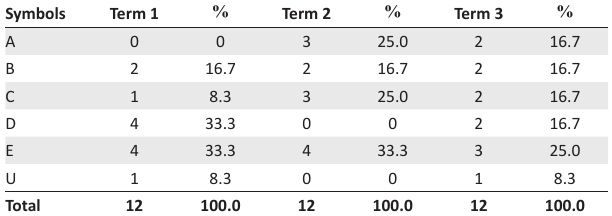
TABLE 5: Mathematics ( N = 12 ). Symbols Term 1